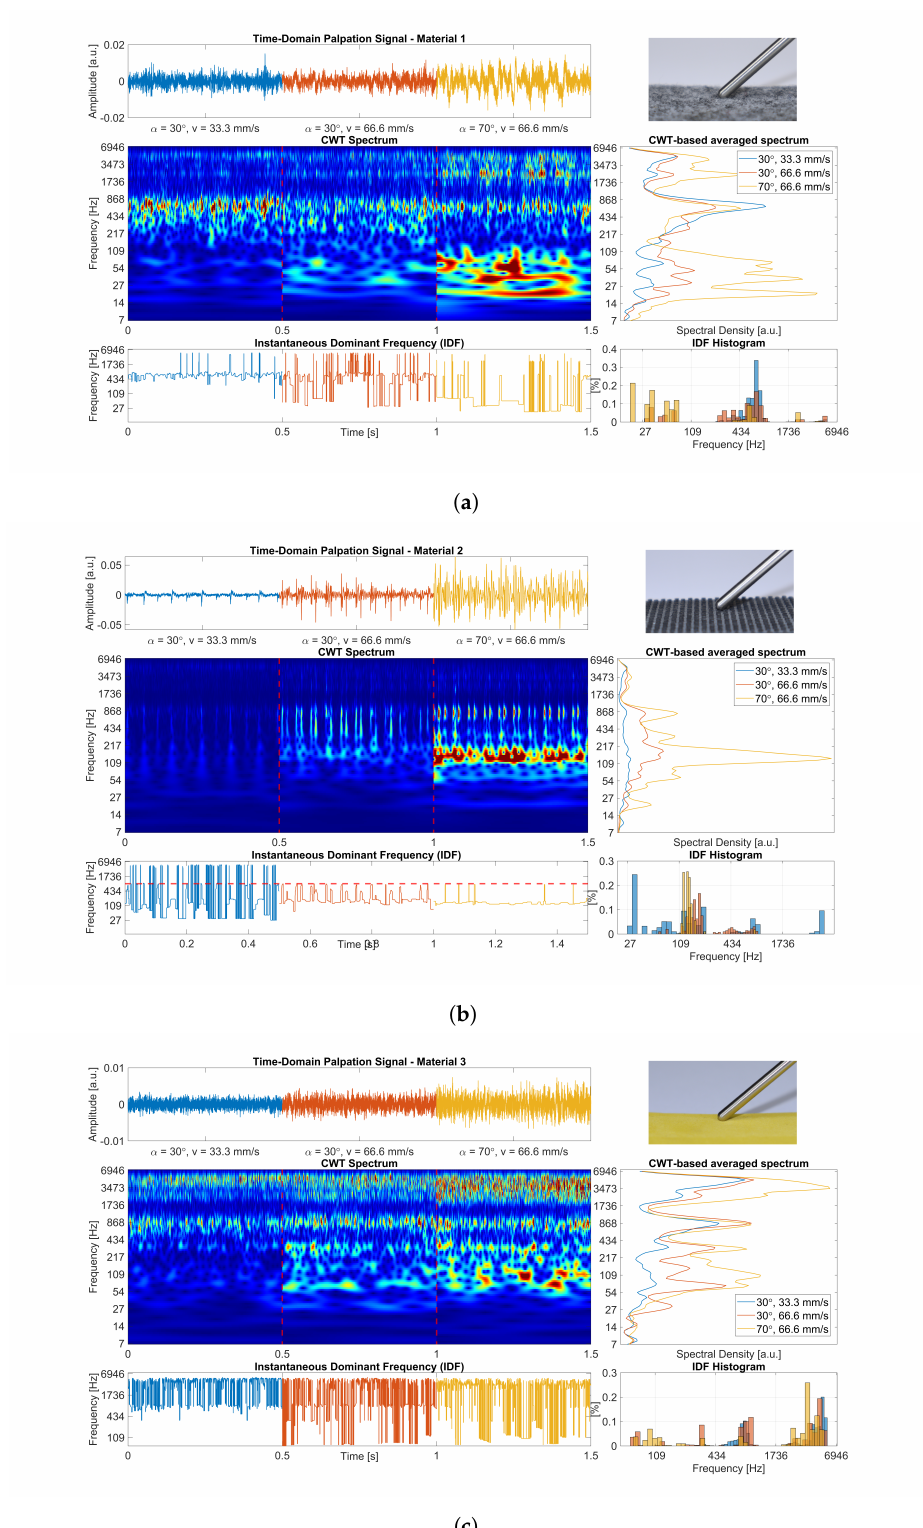
Figure 4. Exemplary palpation signals for Exp. 1 (blue), Exp. 2 (orange), and Exp. 3 (yellow) for the materials M 1 —felt ( a ), M 2 —studded rubber ( b ), M 3 —foamed plastic ( c ). The dashed line (red) in the IDF plot of ( b ) indicates 850 Hz. In the top-right corner, the instrument in contact with the respective material is shown. The CWT-based spectrum and the computed indicators IDF, IDF’s histogram, and stationary spectrum are